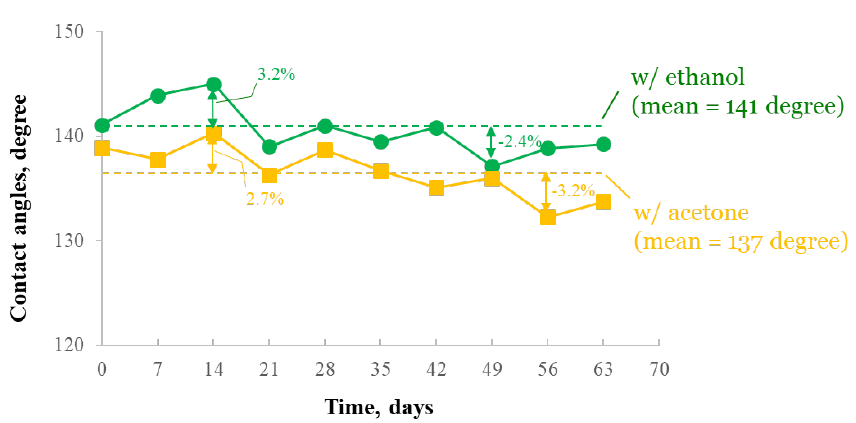
Figure 8. CAs with ethanol or acetone versus time at a temperature of 27 °C.